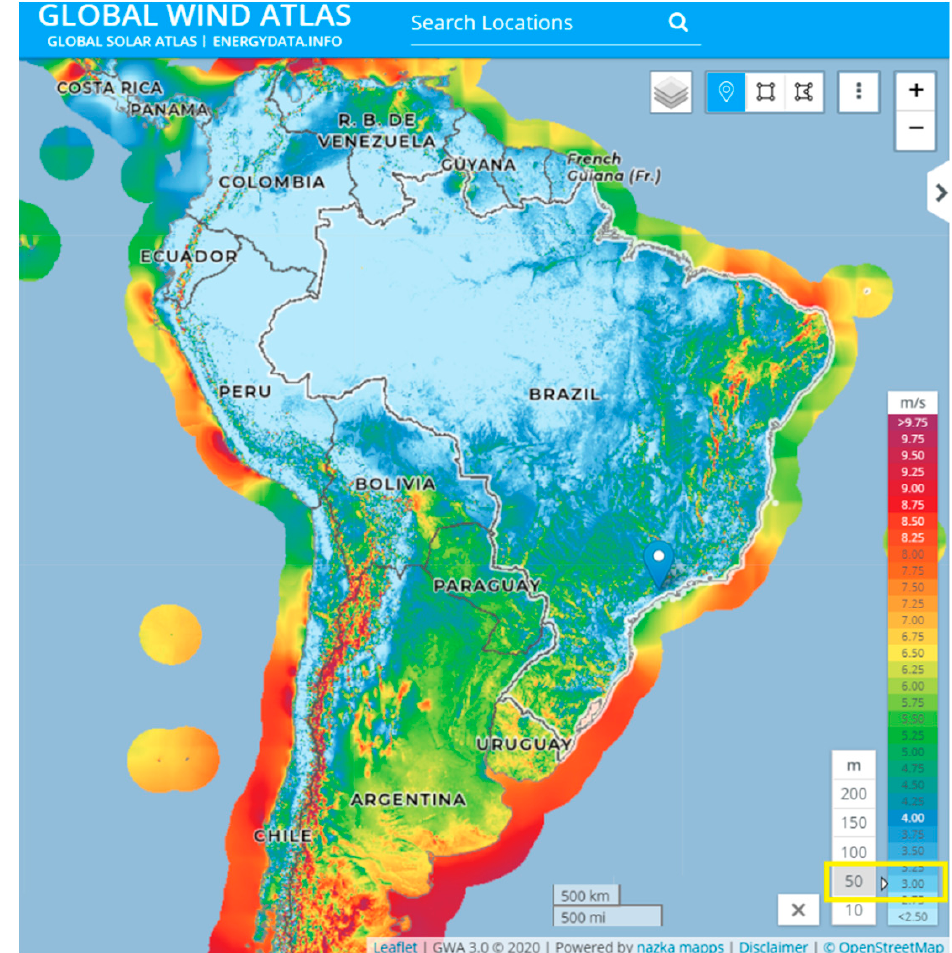
Figure 4. Mean wind speed map showing the SWT location pinpoint (adapted from [21]).